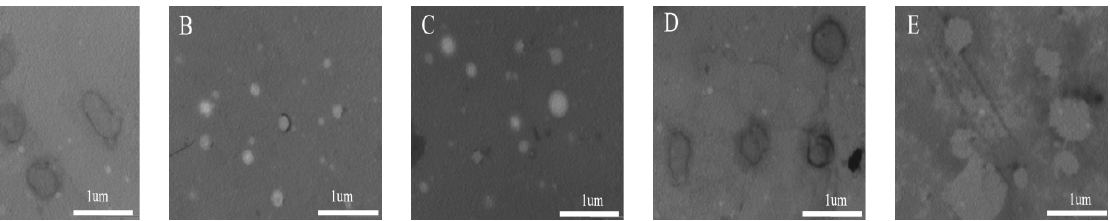
Figure 9. TEM of C n DDGPB at 5.0 mmol/L:( A ) C 8 DDGPB, ( B ) C 10 DDGPB, ( C ) C 12 DDGPB, ( D ) C 14 DDGPB, ( E ) C 16 DDGPB.